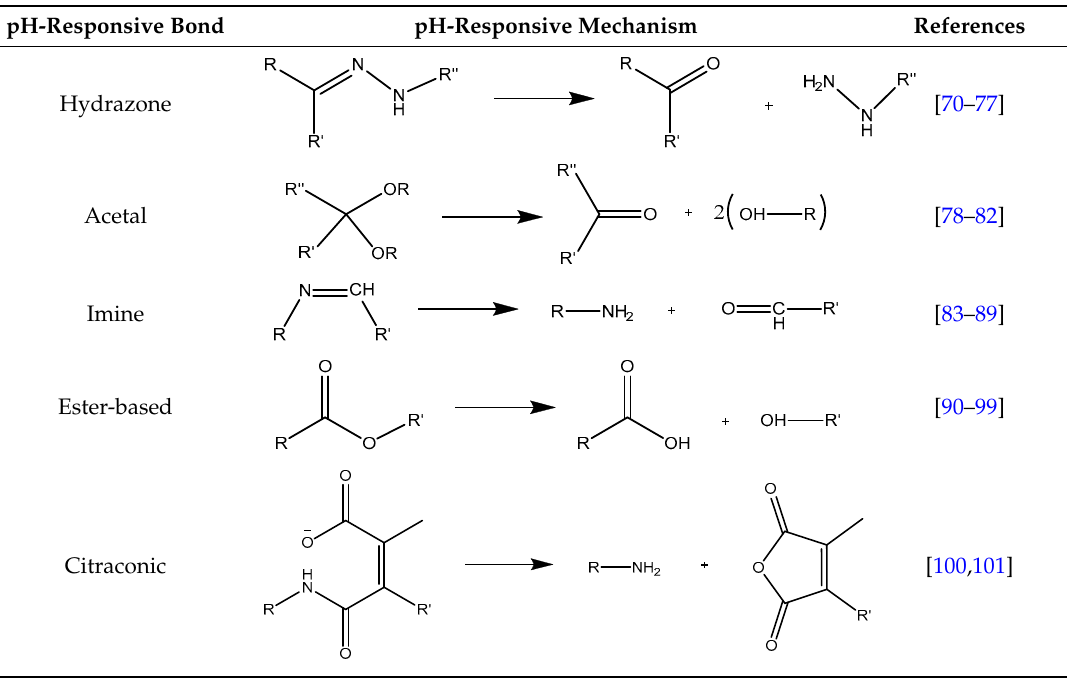
Figure 4. Mesoporous silica nanoparticle (MSN)-doxorubicin (DOX) via hydrazone bond on the surface. The acid-labile bond is cleaved at acidic pH, and the drug is released only in the desired area. DOX can be conjugated to the external surface of the carrier [71] or to the inner pore surface [72]. This last approximation provides a more sustained release because DOX is retained by both the